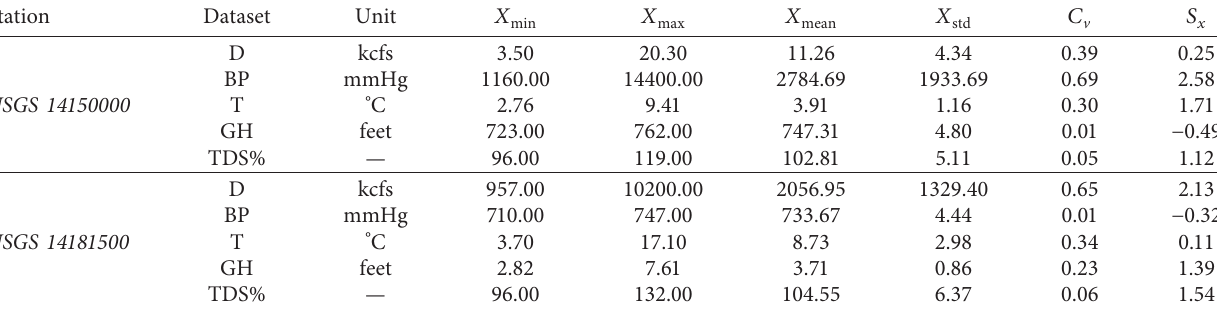
Table 1: Statistical variables of adopted dataset for both